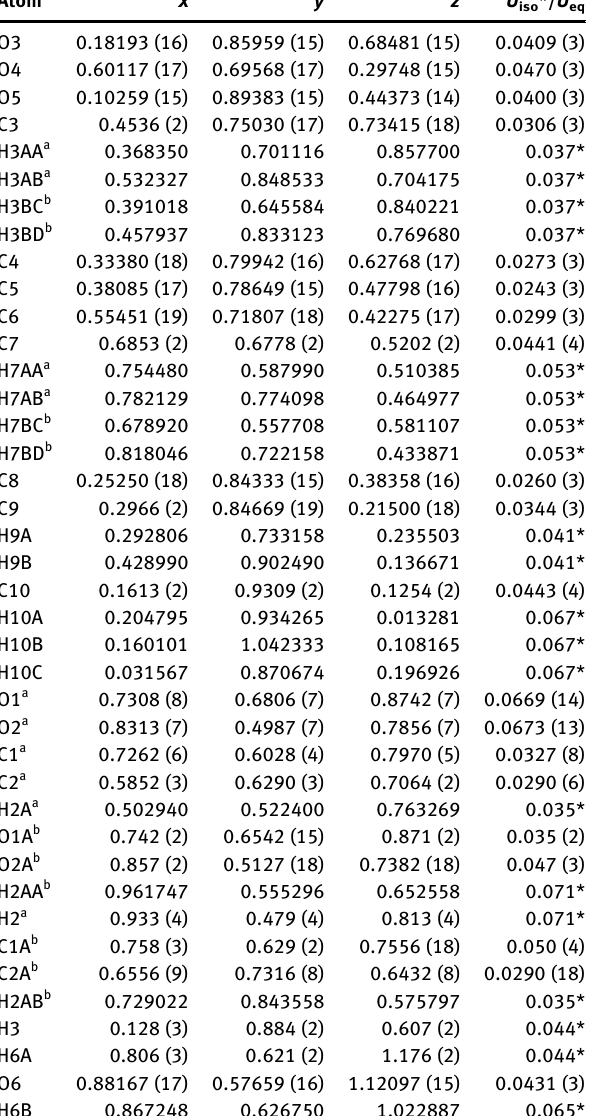
Table  : Fractional atomic coordinates and isotropic or equivalent isotropic displacement parameters (Å 